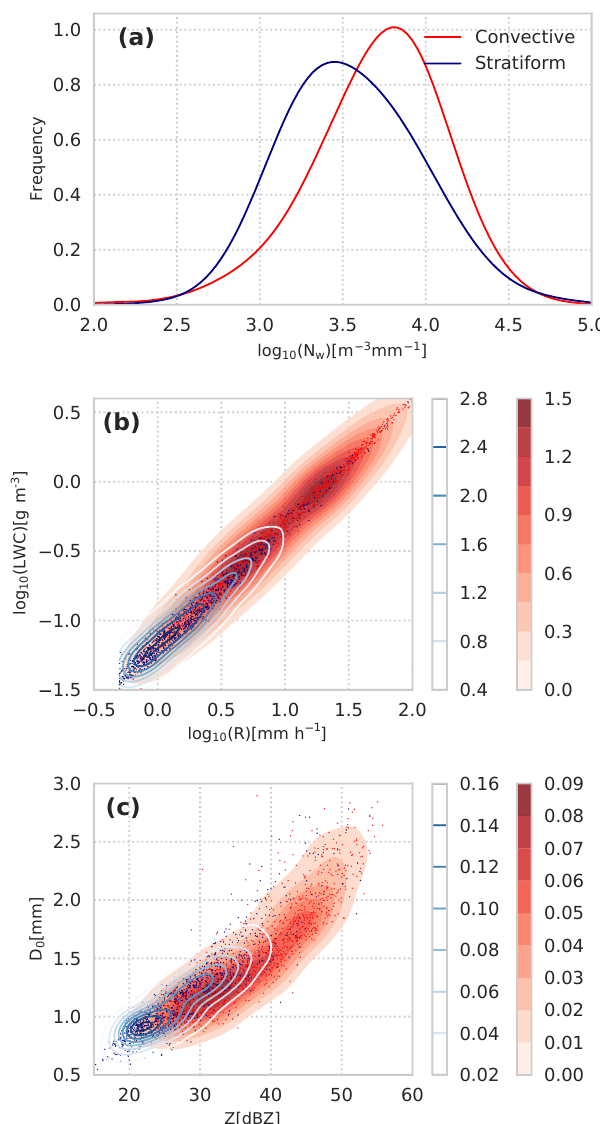
Figure 4. Histograms associated with RWP classification-based convective (red) and stratiform (blue) DSDs in terms of N w (a) , LWC versus R behaviors (b) and D 0 scaling according to Z (c) . Density is shown on the color